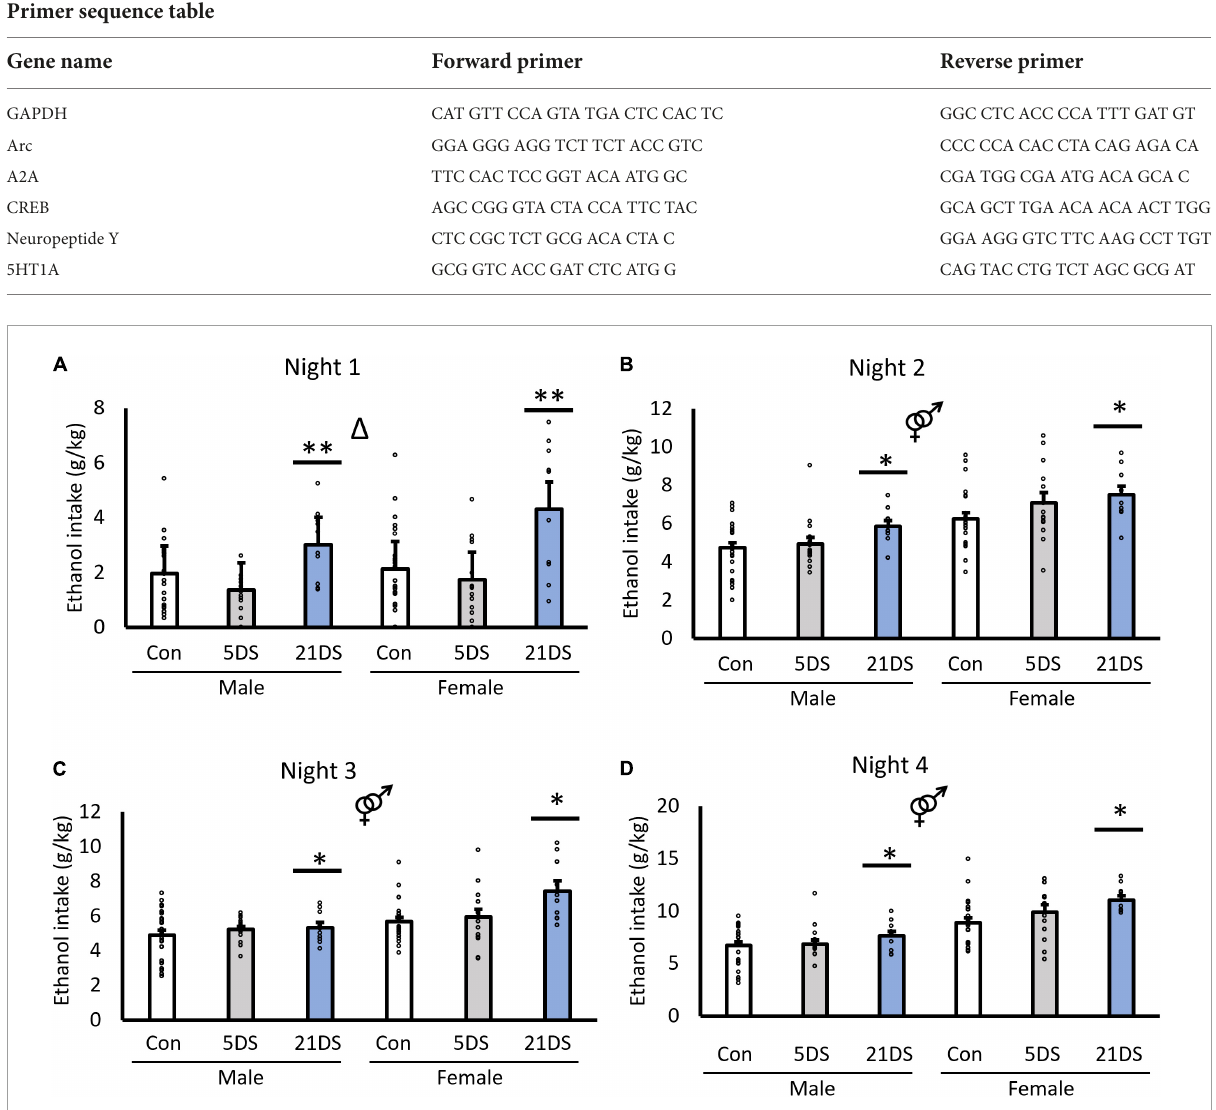
TABLE 1 A list of the primer sequences used for real-time PCR.